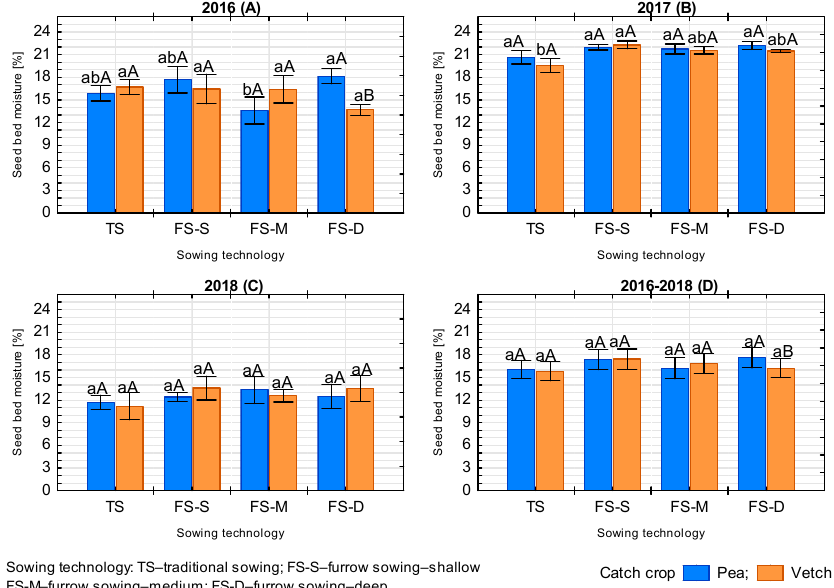
Figure 4. Interaction between research factors in shaping seedbed moisture immediately after sowing seeds [% vol]. a,b—homogenic groups HSD ( p = 0.05) interaction for sowing method/species (the differences between the four methods of sowing separately for pea and for vetch); A,B—homogenic groups HSD ( p = 0.05) interaction for species/sowing method (differences between pea and vetch for each sowing method).